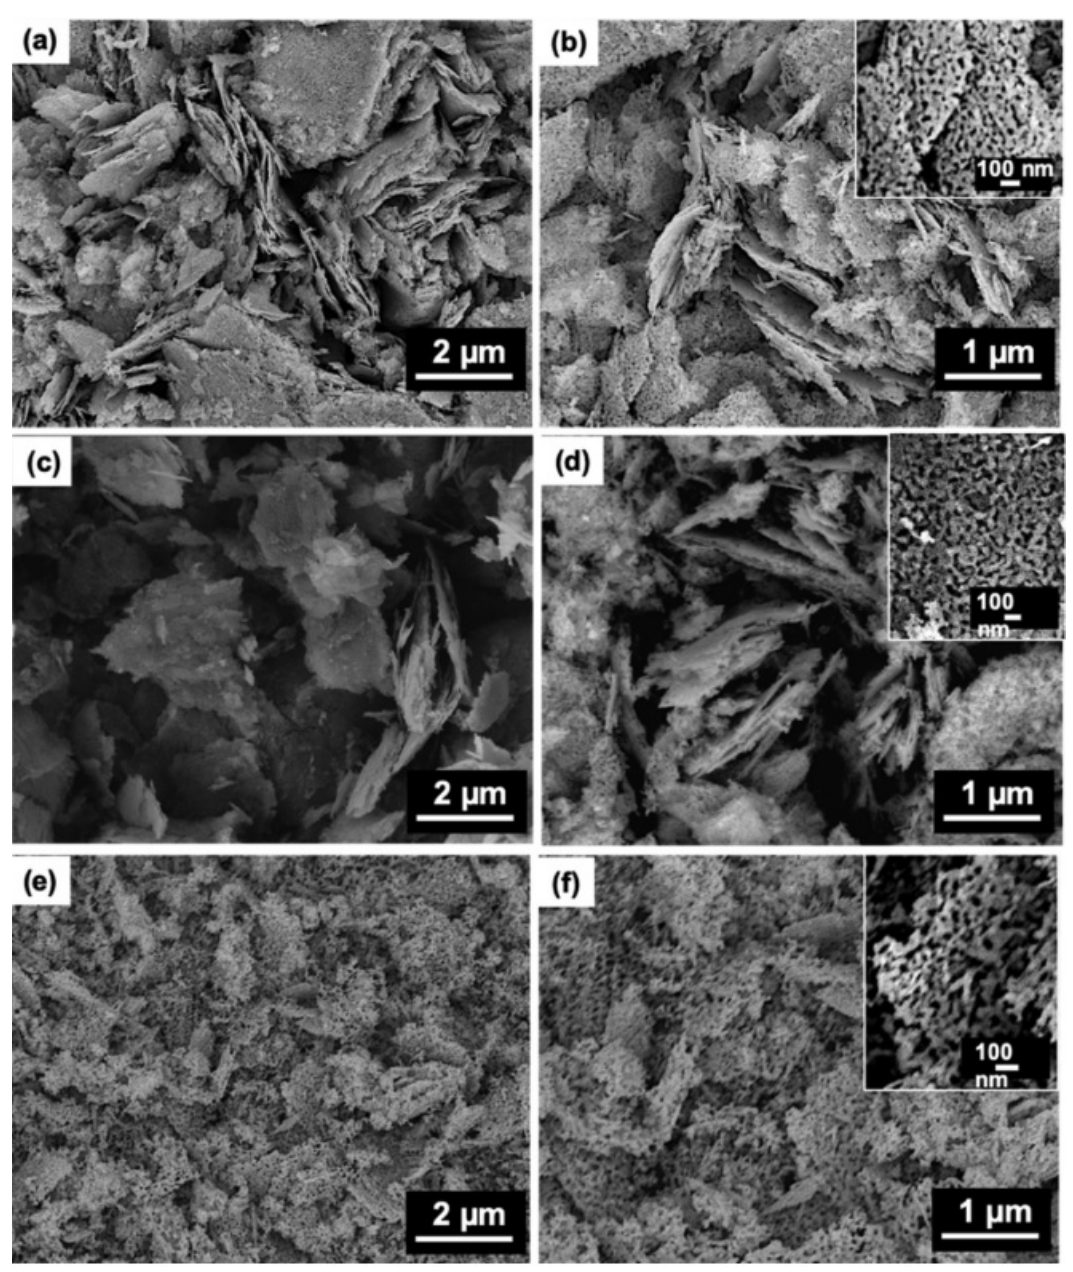
Figure 9. SEM images of ZnO ‐ In 2 O 3 porous nanosheets of various compositions synthesized by solvothermal method at different magnifications: ( a , b ) –Zn 2+ /In 3+ = 10:0 M ratio; ( c , d ) Zn 2+ /In 3+ = 10:2 M ratio, and ( e , f ) Zn 2+ /In 3+ = 10:6 M ratio. Reprinted with permission from Yan et al. [82]. Copyright 2021: